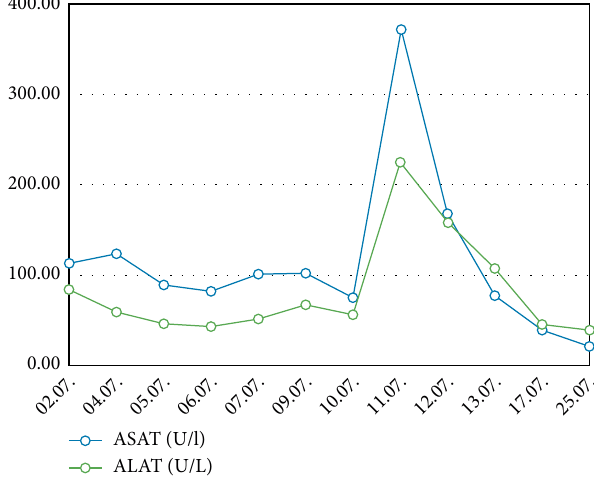
Figure 6: Different laboratory parameters over time. ASAT: Aspartate-Aminotransferase. ALAT: